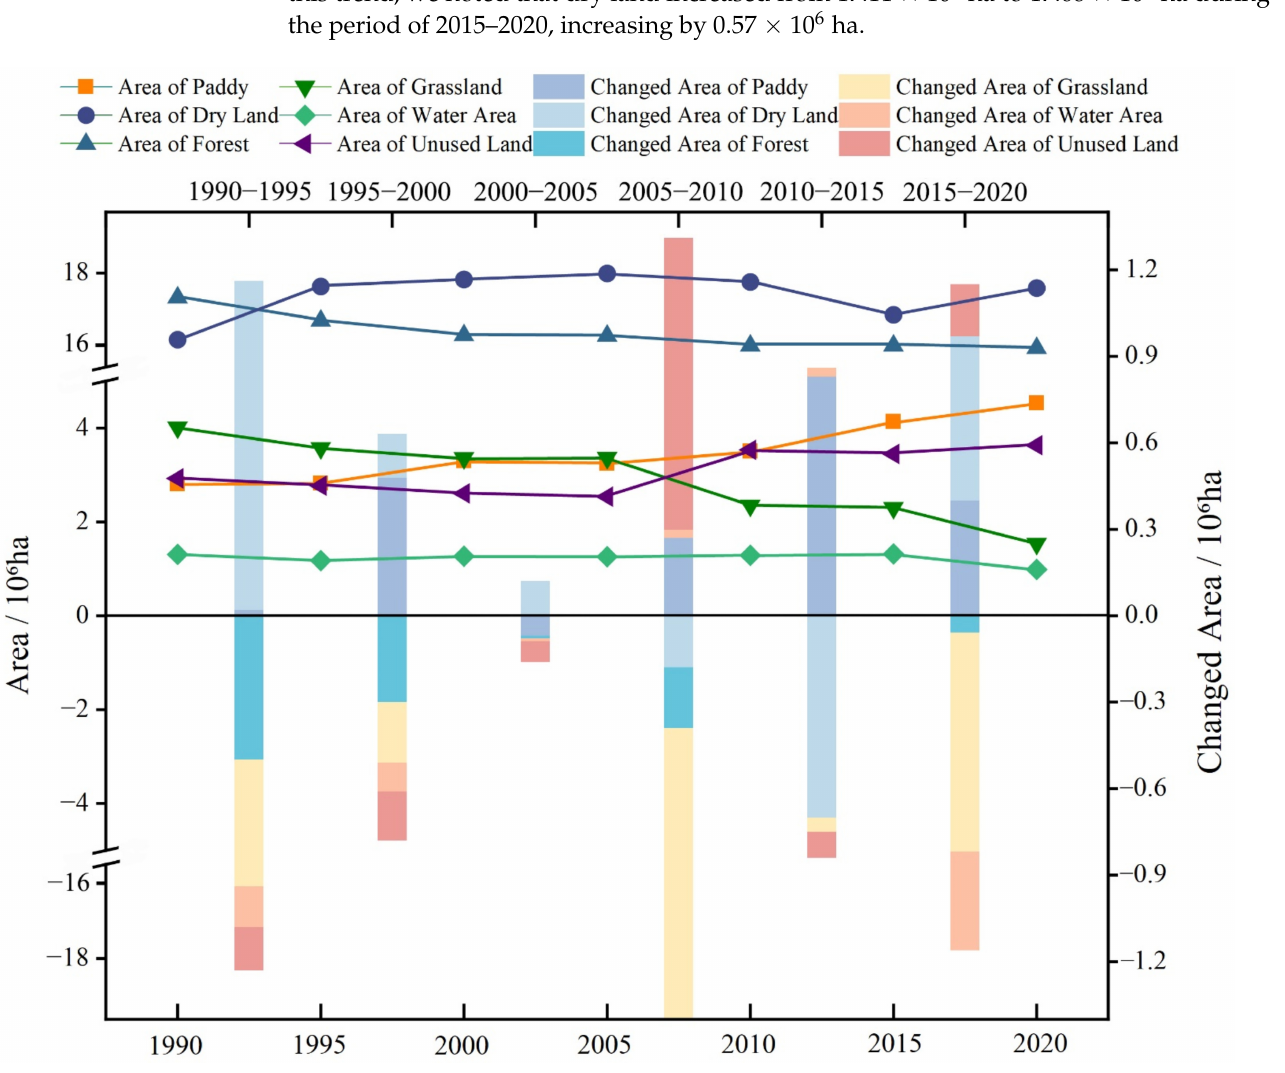
Figure 2. Temporal variations in land-use in the